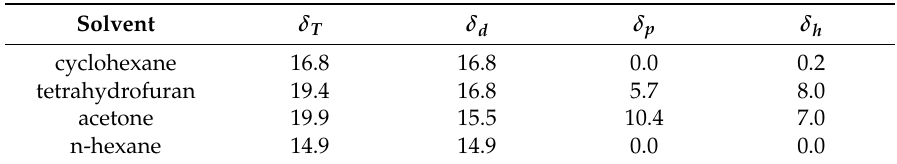
Table 2. Hansen parameters (units MPa 0.5 ) of solvents used in this study [17]. δ T is the total solubility = δ 2 + δ 2 + δ 2 parameter, δ 2 p T d h